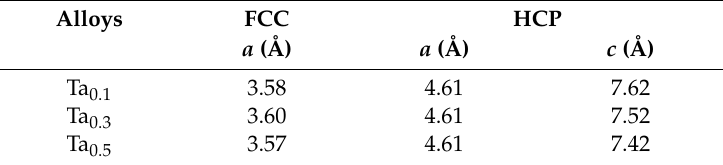
Table 2. Lattice constants of the phases in the as-cast CoCrFeNiTa x alloys.